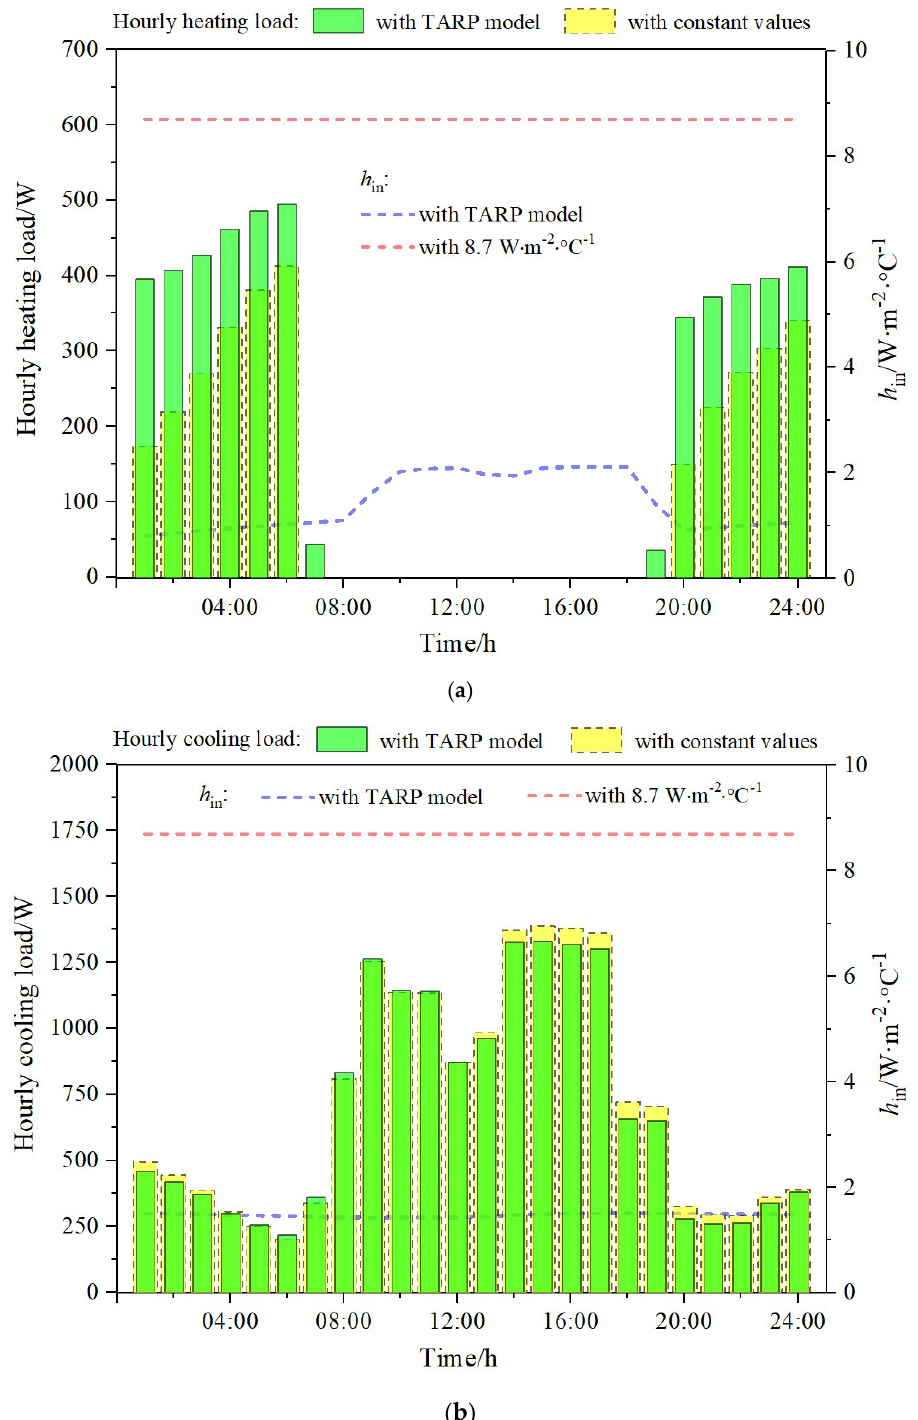
Figure 6. Comparisons of hourly loads with different internal SHTCs on a typical day: ( a ) Hourly heating load on a typical day in winter; ( b ) Hourly cooling load on a typical day in summer.